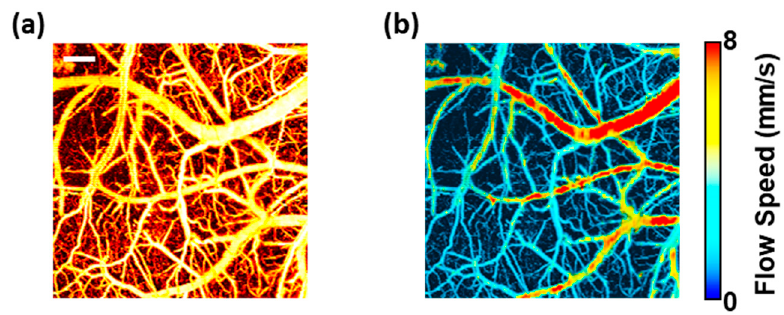
Figure 11. ( a ) Maximum amplitude projection (MAP) image. ( b ) Blood flow image. Scale bar in ( a ) is Figure 11. (a) Maximum amplitude projection (MAP) image. (b) Blood flow image. Scale bar in (a) is 250 µ 250 μ m.